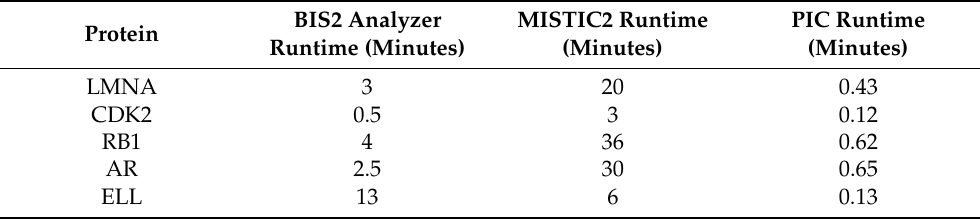
Table 3. Runtimes in minutes for three different calculators, including our own, on 5 different randomly selected proteins. Though our calculator is designed for intra-protein interactions, it can easily be used for inter-protein interactions. The reverse is not true for the other calculators. Hence, this test was conducted on inter-protein relationships. Note that runtimes are approximate and based on email notifications of when jobs started and finished for BIS2Analyzer and MISTIC2. BIS2 Analyzer MISTIC2 Runtime PIC Protein Runtime (Minutes) (Minutes)